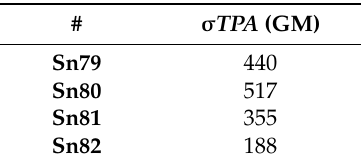
Table 11. Largest TPA observed in chloroform for Sn79 – Sn82 .